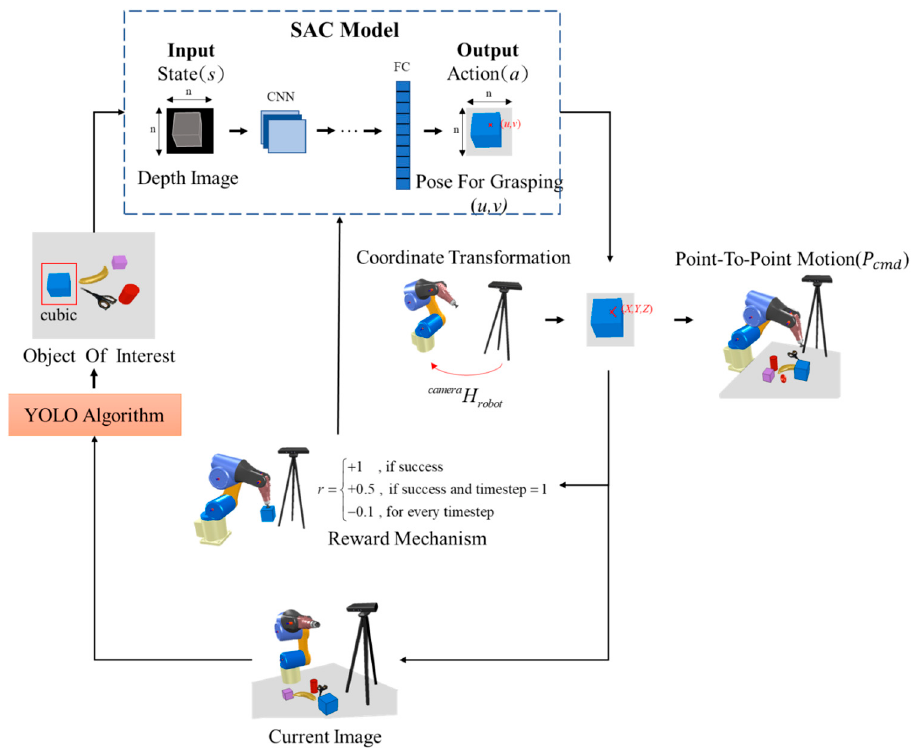
Figure 1. Schematic diagram of robotic pick-and-place based on computer vision and deep reinforcement learning.